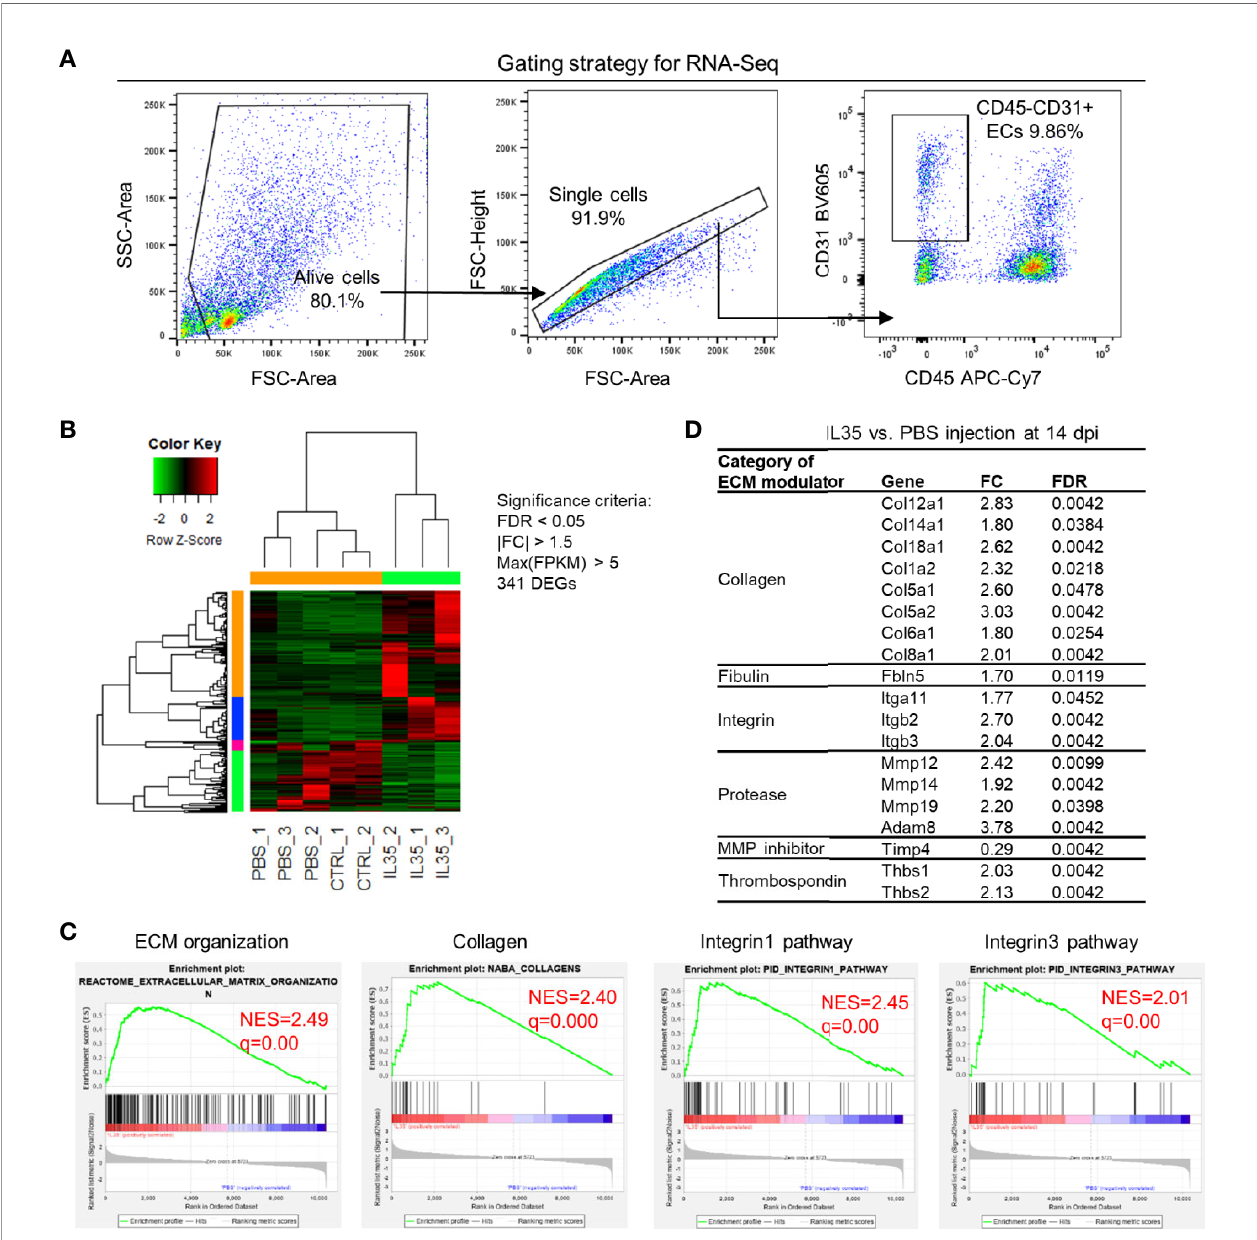
FIGURE 4 | Transcriptome analysis of endothelial cells (ECs) at 14 days post-ischemia (dpi) reveals a disturbed extracellular matrix (ECM) reorganization in the IL-35- injected mice. (A) Flow cytometry cell sorting strategy. Hindlimb muscle from control (Ctrl, without surgery) or ischemic mouse (PBS and IL-35 groups) at 14 dpi was dissected and digested for single cell suspension. Cells were stained with the surface markers of CD31 BV605 and CD45 APC-Cy7 and sorted by Aria Cell Sorter (BD Biosciences). 1 × 10 5 cells of ECs from each sample were collected for RNA extraction and deep-sequencing. (B) Heatmap of the differentially expressed genes (DEGs) in ECs of IL-35- or PBS-injected, and control groups. With the criteria of false discovery rate (FDR) < 0.05, |FC| > 1.5, and max (fragments per kilobase of transcript per million mapped reads, FPKM) > 5, we got 341 DEGs. The green-red color key was scaled based on the z-score of FPKM within the row. (C) Gene set enrichment analysis (GSEA) of the gene expression changes of ECs in IL-35-injected mouse compared to that of PBS group. Four of the most enriched pathways were presented. (D) Representative gene expression changes in different categories of ECM proteins. All results were collected from male mice. n =